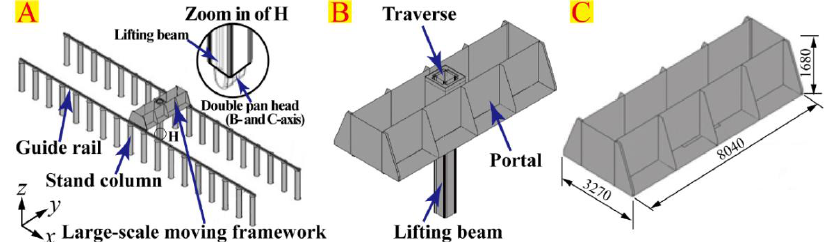
Figure 1. Preliminary design of the L5AMC: ( A ) overall layout; ( B ) large-scale moving framework; ( C ) portal.